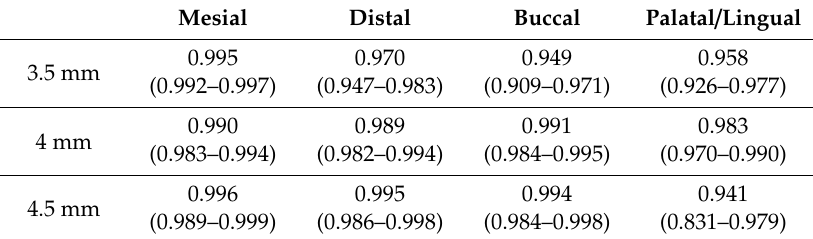
Table 4. ICC value achieved according to implant diameter p < 0.001 (CI 95%).